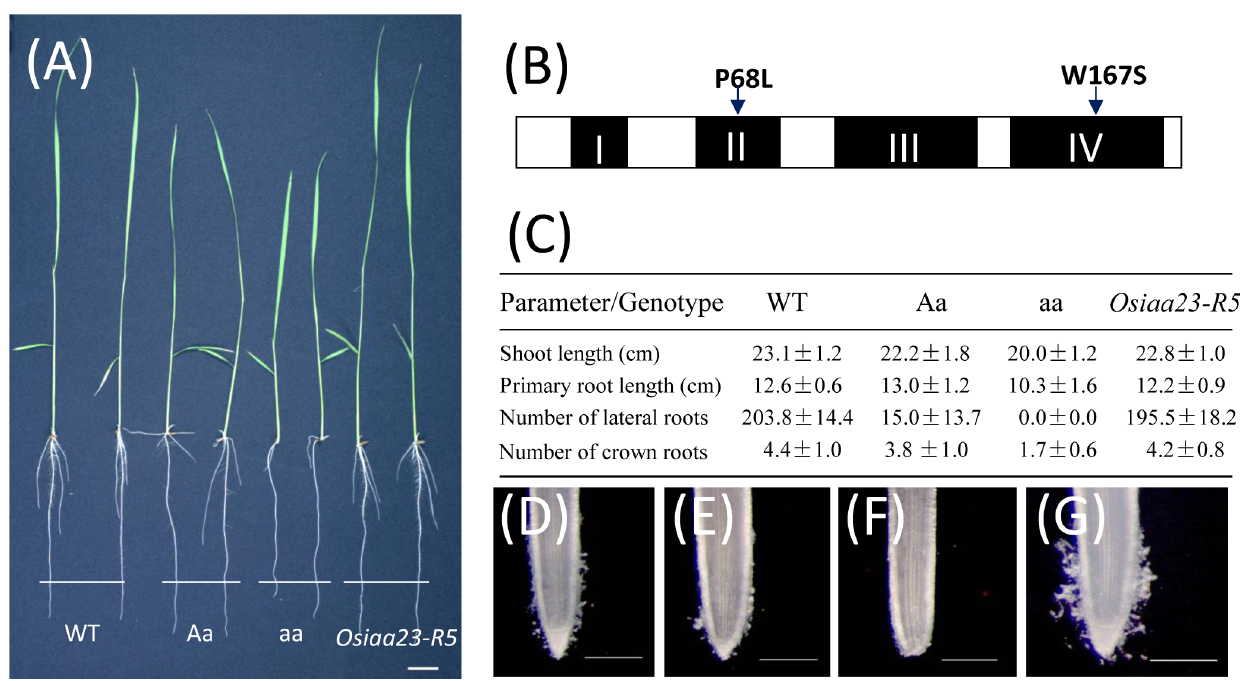
Figure 1. Intragenic mutation in Domain IV fully rescued the defects of Osiaa23-3 mutant. (A) Phenotypes of 7-day-old seedlings of wild type (WT), heterozygous mutant of Osiaa23-3 (Aa), homozygous mutant of Osiaa23-3 (aa) and the suppressor of Osiaa23-3 , Osiaa23-R5 . Bar =2 cm. (B) Diagram of conserved domains of OsIAA23. Black rectangles marked by Roman numerals indicate four domains of OsIAA23, and two mutated sites in Domain II and Domain IV are marked by arrows. (C) Growth parameters of 7-day-old seedlings of WT, Aa, aa and Osiaa23-R5 . (D-G) Root tips of 7-day-old seedlings of WT (D), Aa (E), aa (F) and Osiaa23-R5 (G). Bars =250 m m.